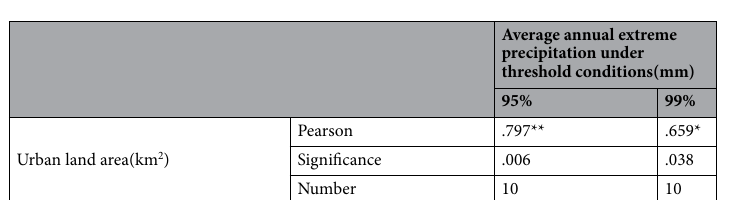
Table 8. Pearson correlation analysis of mean urbanization intensity versus average annual extreme precipitation for 5 periods. ‘‘**’’indicates significant correlation with 0.01 significant level; ‘‘*’’ indicates significant correlation with 0.05 significant level; No labeling indicates that the correlation is not significant.